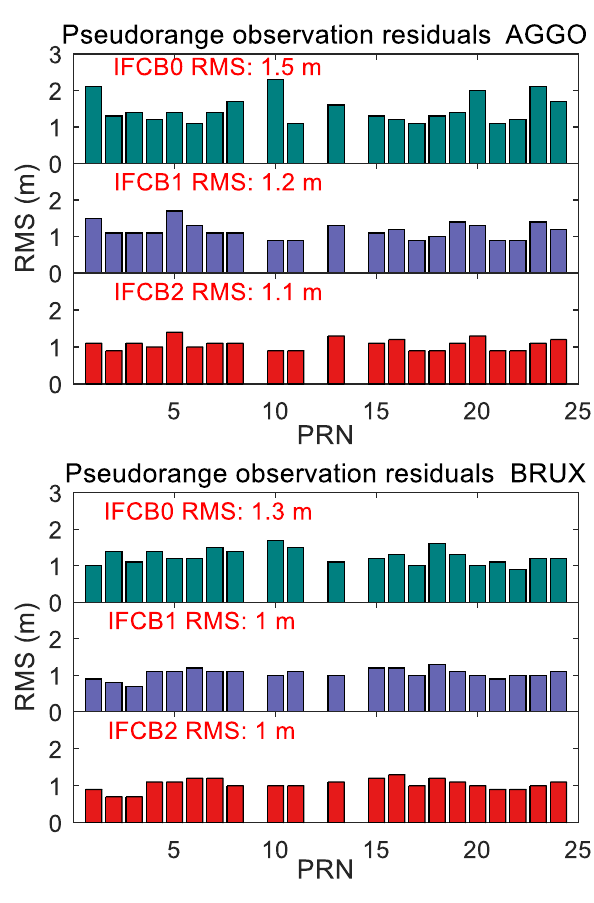
Figure 13. Pseudorange observation residuals of GLONASS PPP at AGGO and BRUX on DOY 227, 2017.